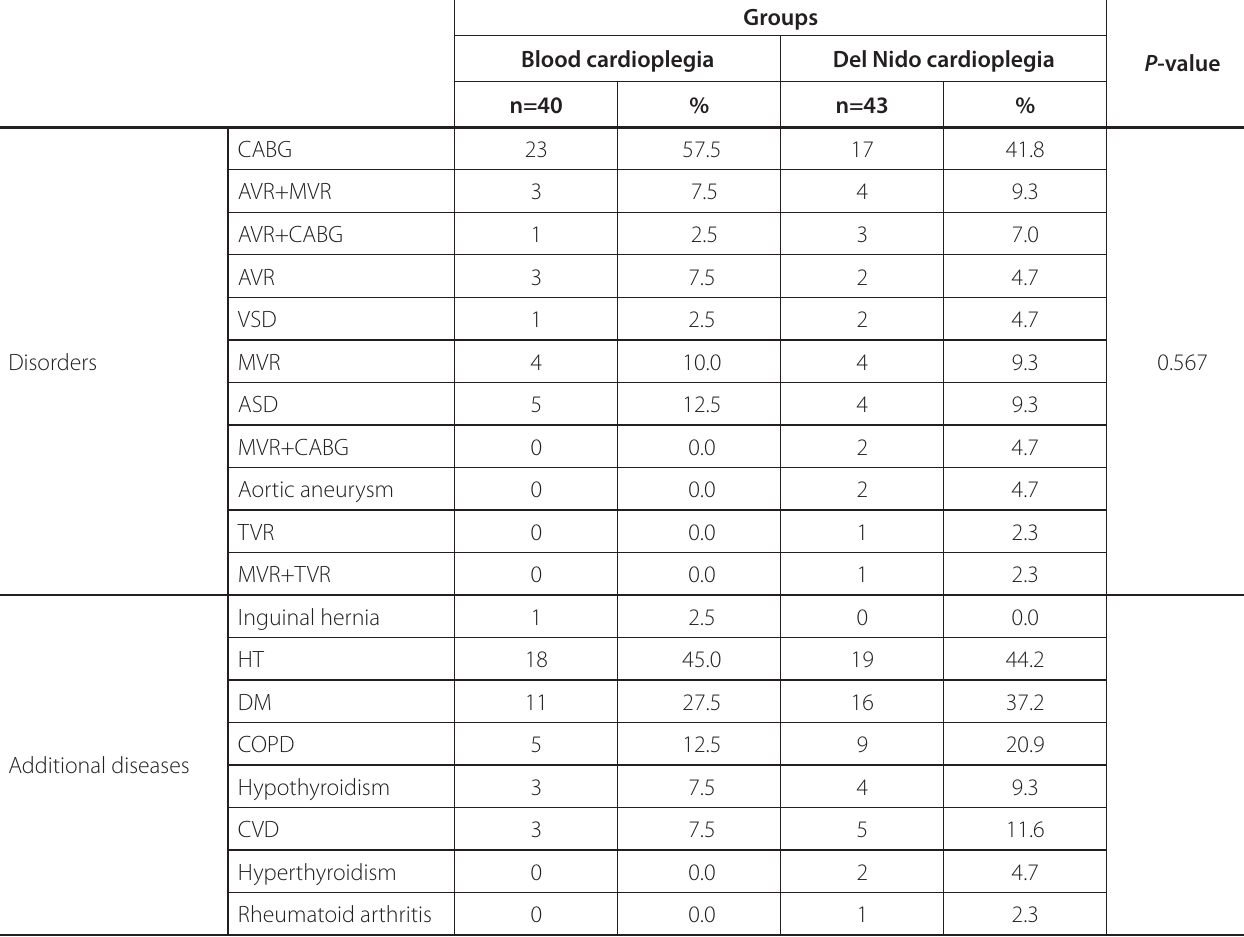
Table 3 . Distribution of diseases and comorbidities.